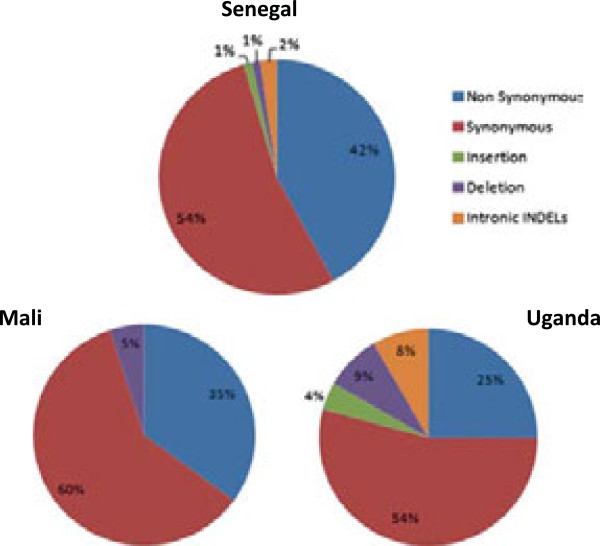
Frequency of polymorphism occurrence in thepfhrp2gene from Senegal, Mali, and Uganda isolates. Non-synonymous, synonymous, coding indels polymorphisms were observed. Synonymous and non-synonymous SNPs are the more common polymorphism in the three populations. Synonymous SNPs are higher than non-synonymous SNPs, showing variability between countries. Intronic indels and coding insertion were not observed in Mali.